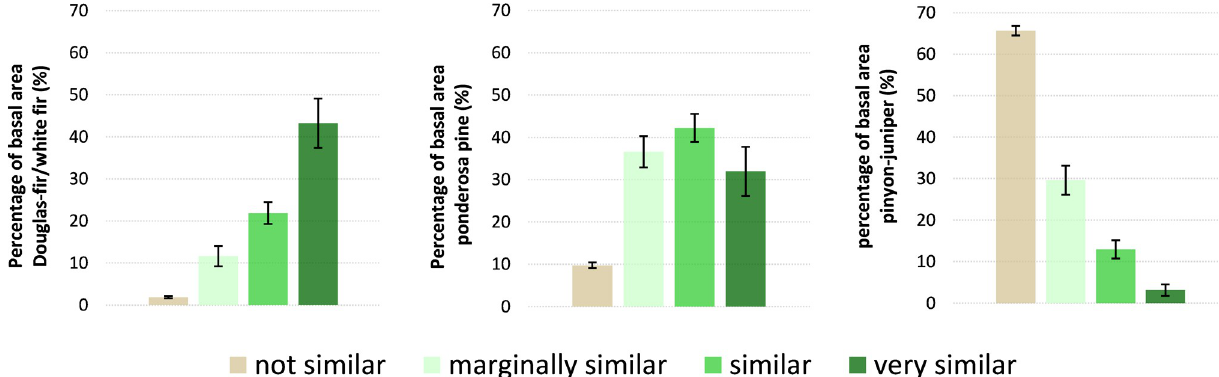
Fig 4. Forest species composition of cover type spectral similarity map classes. Height of bars represents mean and 95% confidence intervals are shown in error bars.